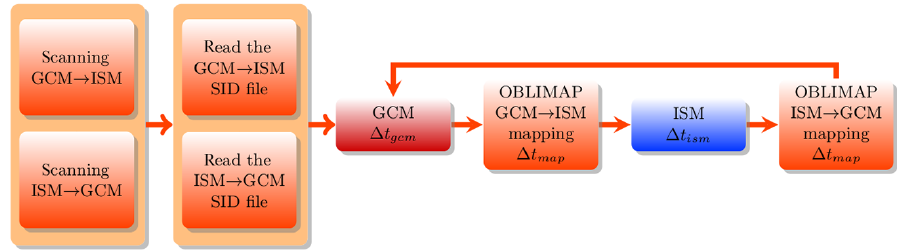
Figure 2. Schematic representation of an embedded ISM within a GCM run. At the initialization of the online coupled run the SID files are read, which have been created by offline scanning prior to this run. The GCM and ISM are coupled with the embedded OBLIMAP routines at each coupling interval (cid:49)t map . The GCM and the ISM evolve with their own time step (cid:49)t gcm and (cid:49)t im depending on their specific numerical stability